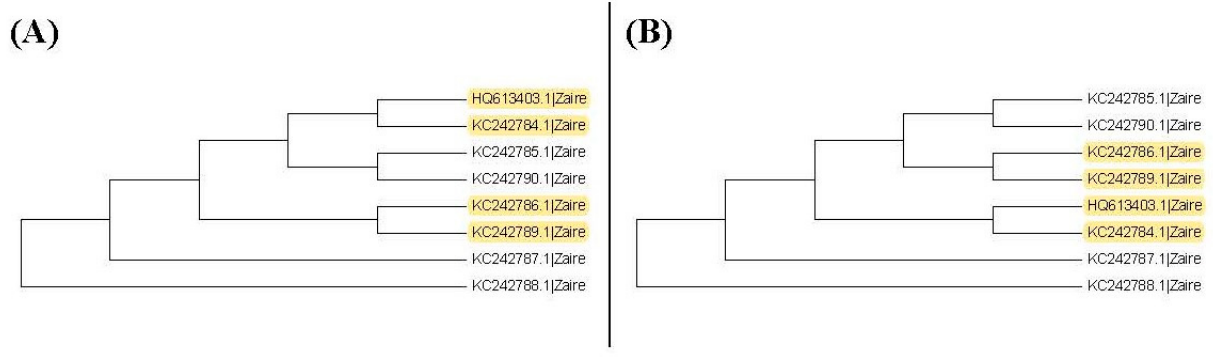
Figure 9. The neighbor-joining trees for the subgroup of ebolavirus sequences. Yellow color: differ- ence. ( A ) Other models exclude K80 model and the Tamura 3-parameters model; ( B ) K80 model and the Tamura 3-parameters model.